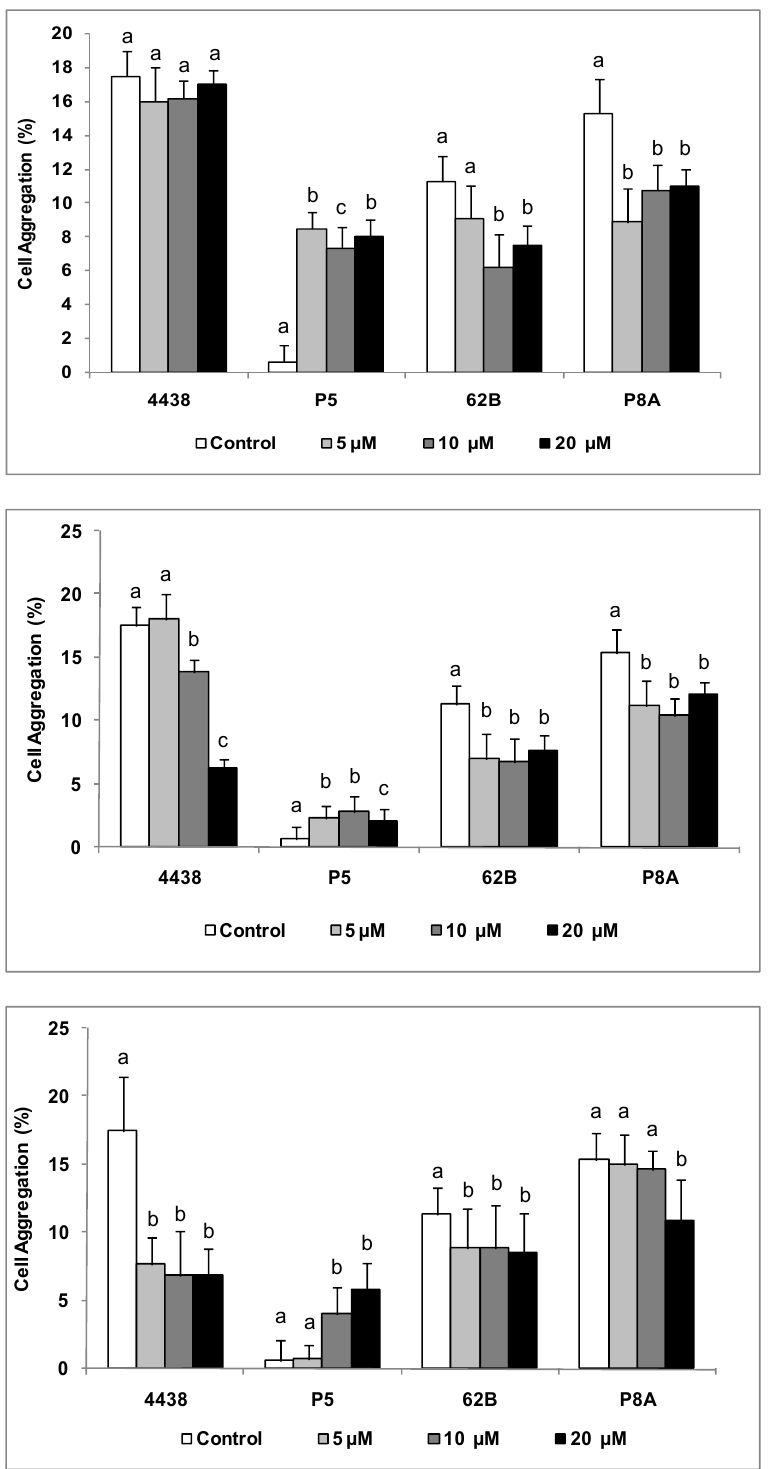
Figure 5. Effect of AHLs on cell aggregation of peanut-nodulating